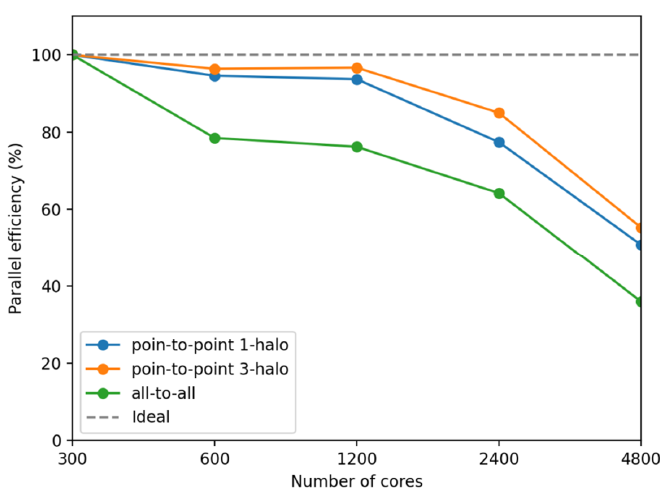
Figure 7. Parallel efficiency of the three main communication patterns of the presented code on a computational mesh of 800 × 256 × 240 cells.